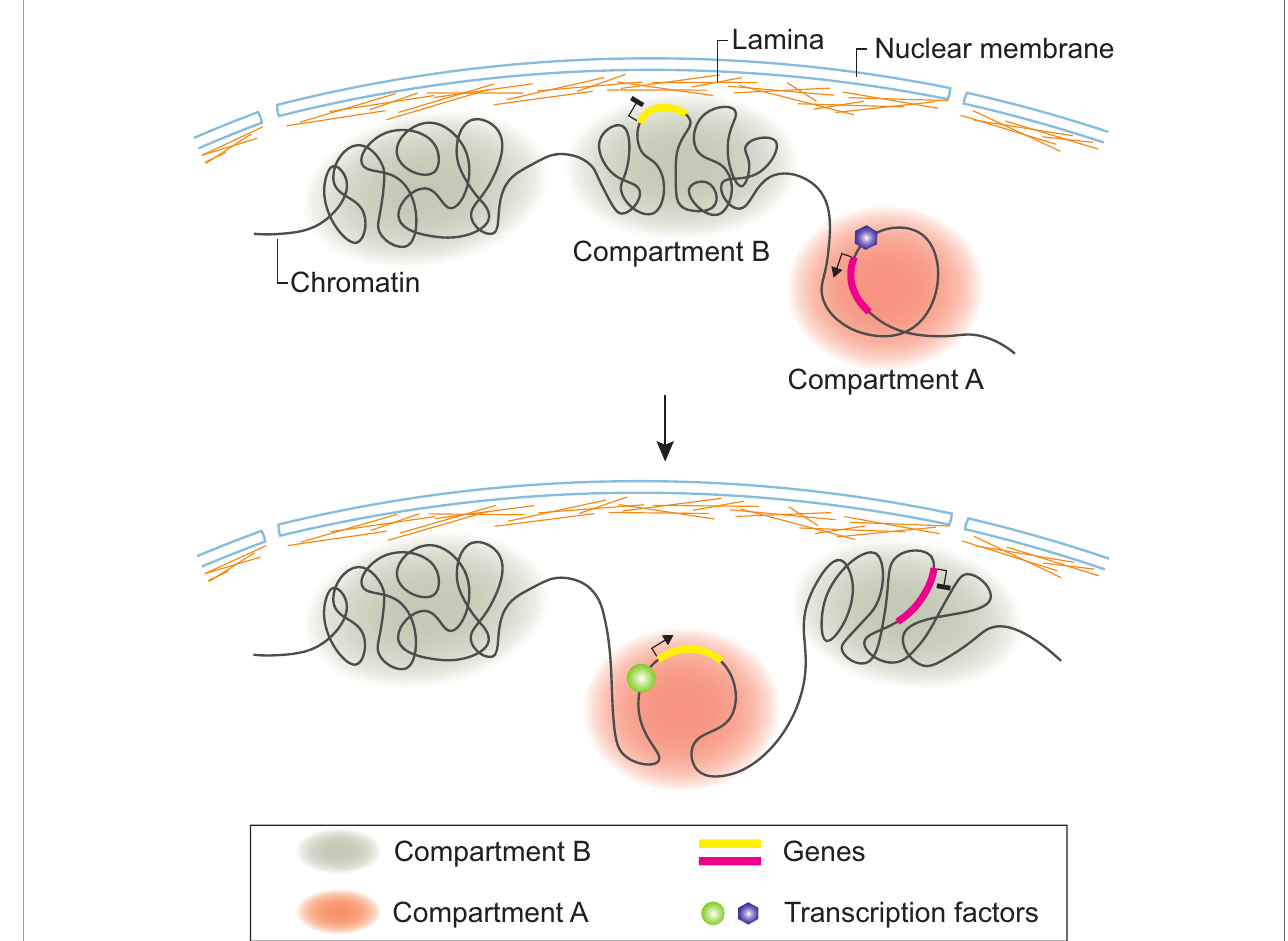
FIGURE 2 | Compartment switch in B cell and T cell lineage commitment. Loci of B or T cell lineage speci fi c genes dissociate from nuclear lamina and are fl ipped from inactive B compartment to active A compartment. Compartment switch is accompanied by expression of speci fi c transcription factors regulating target gene